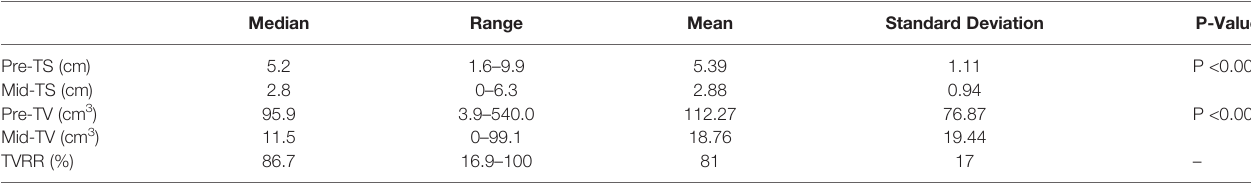
TABLE 3 | The range of tumor parameters and the changes before and after